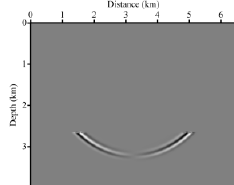
Figure 7. Filtered wavefield: ( a ) downgoing; ( b ) upgoing; ( c ) Leftgoing; ( d ) rightgoing.